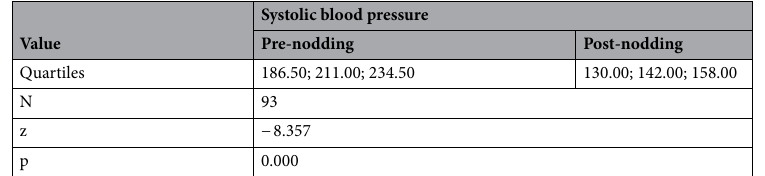
Table 7. Comparison of systolic blood pressures before and after the head-nodding period (Wilcoxon rank- sum test). Systolic blood pressure was given in